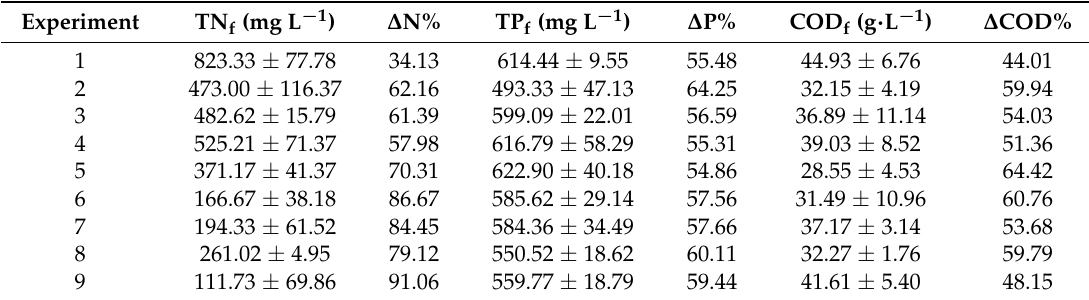
Table 2. Experimental results on decrease of Nitrogen (N), Phosphorus (P) and Chemical Oxygen Demand (COD) in the mycoalgae biofilm supernatant after 120 h of growth.